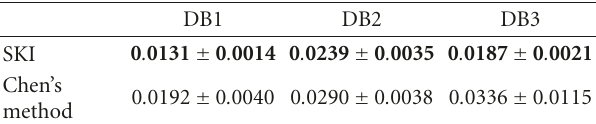
Table 3: Average segmentation error rates (mean ± standard